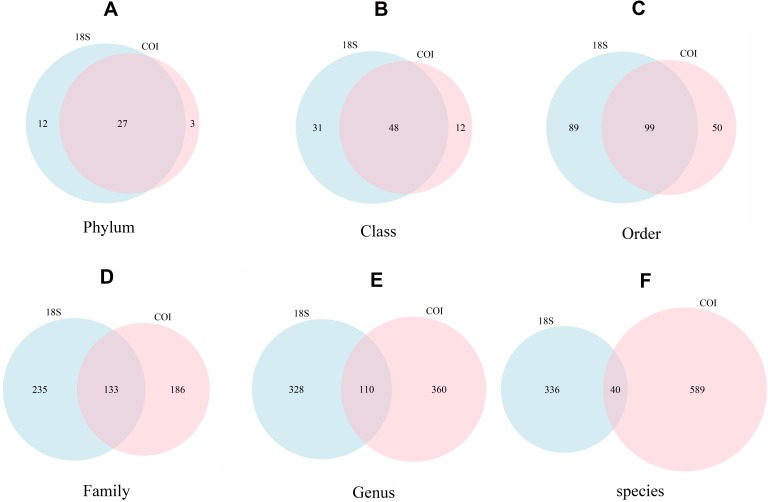
Venn diagrams showing the number of different taxa recovered with 18S (blue) or COI (red) at different taxonomic ranks.(A) Phylum, (B) Class, (C) Order, (D) Family, (E) Genus, (F) species.